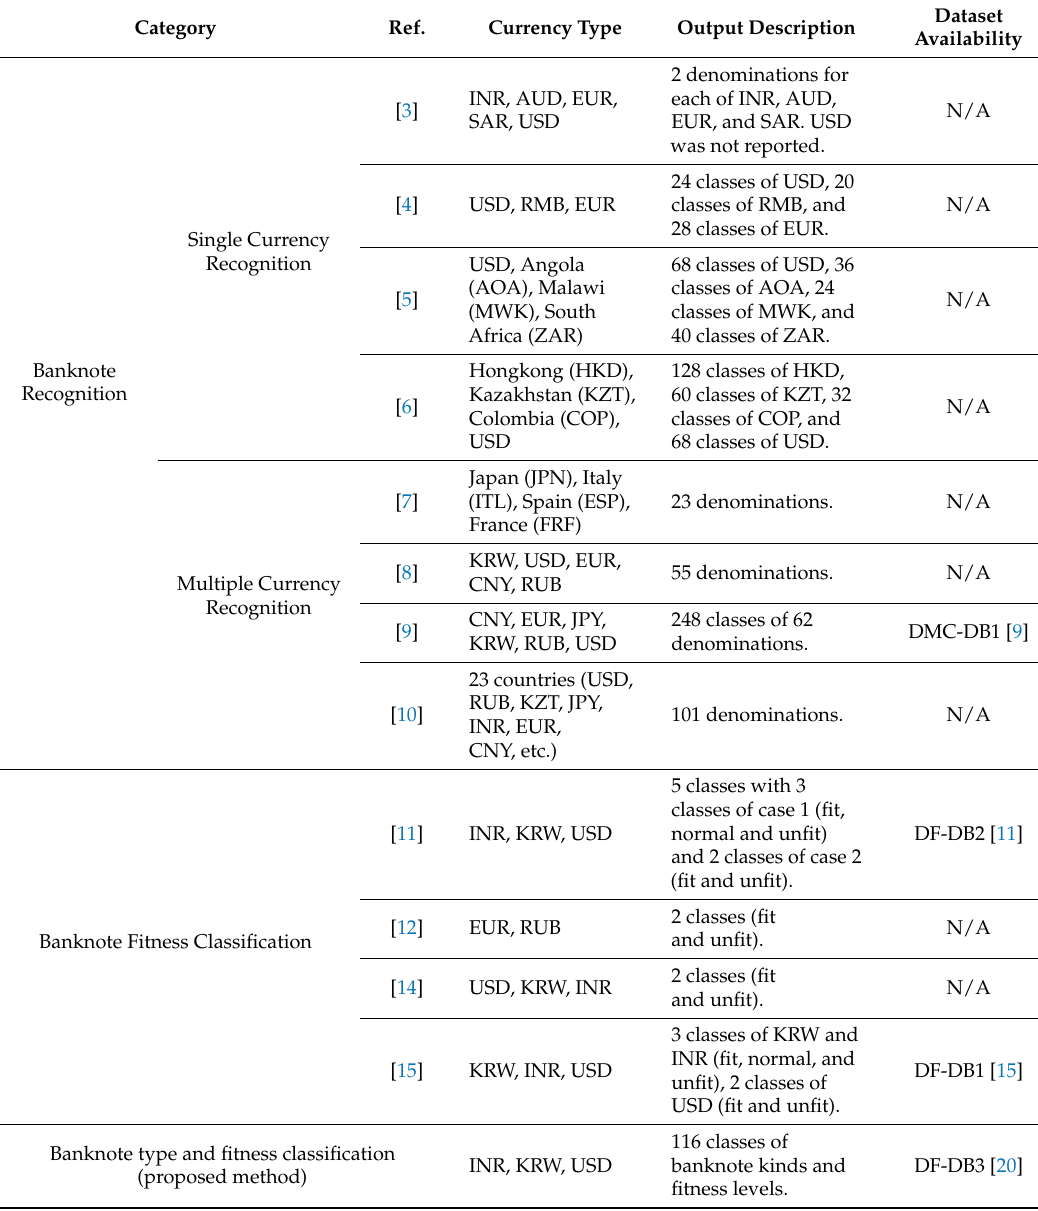
Table 2. Summary of banknote datasets used for experiments in the previous studies (Ref: Reference(s), N/A: Not